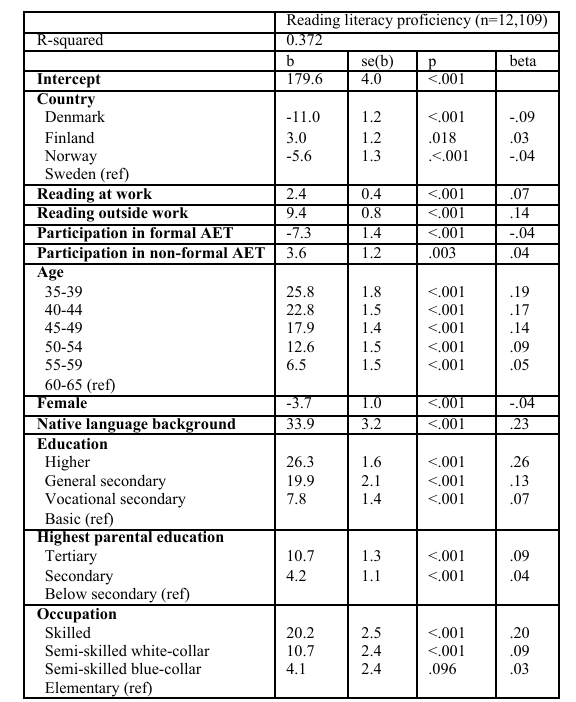
Table 2. Regression model for reading literacy proficiency in four Nordic countries. Beta = standardised regression